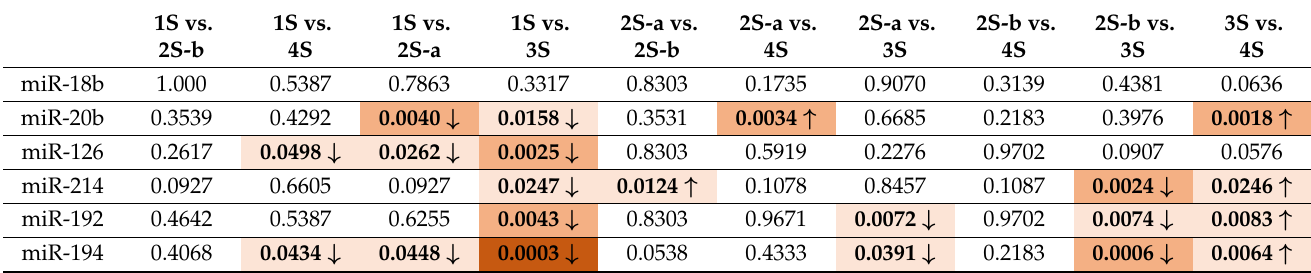
Table 2. Significance of expression differences between groups in the small intestineshown as p values. Up-regulation is marked with an arrow up, down-regulation is marked with an arrow down.